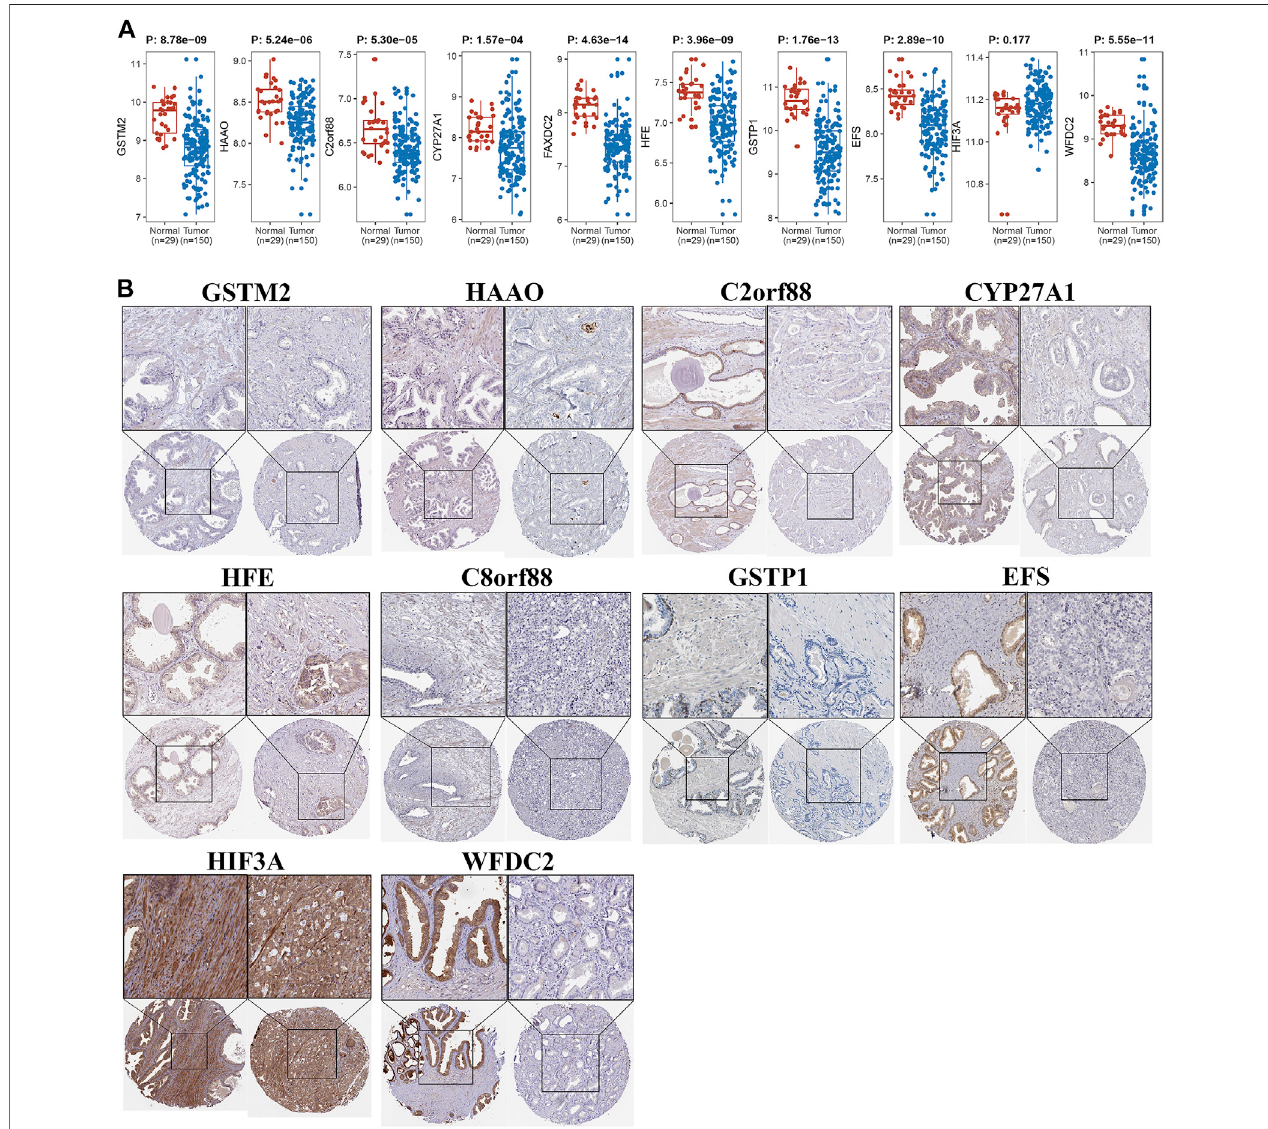
FIGURE 8 | Validation of differential expression of driver genes. (A) Wilcoxon rank-sum test was applied to test gene expressional difference of driver genes between PCa and normal control samples. (B) Protein levels of driver genes were explored in Human Protein Atlas.